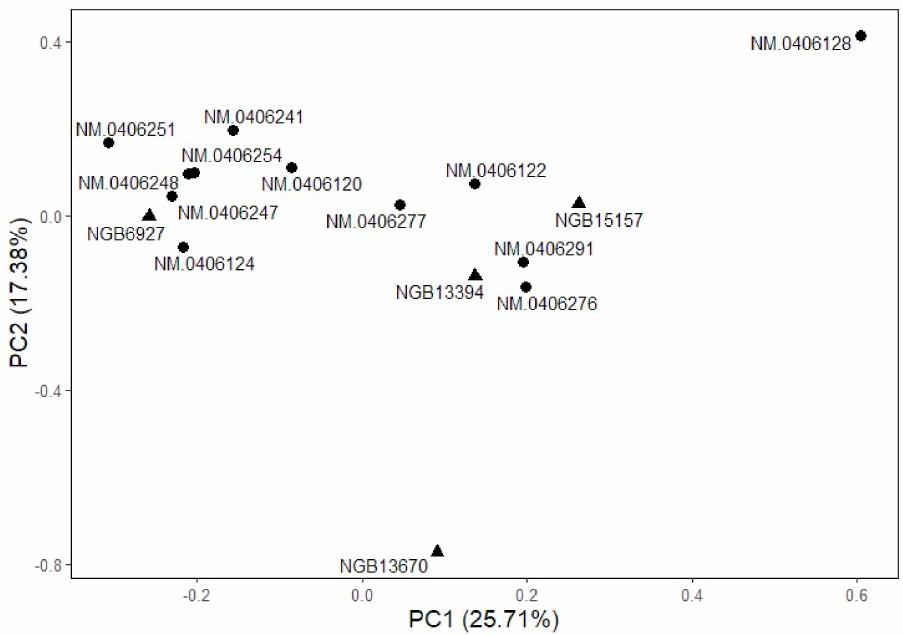
Figure 3. Results of accession level PCA; the percentage on each axis is the amount of variance explained by that principal component. Extant accessions are shown as triangles, and historical accessions are shown as